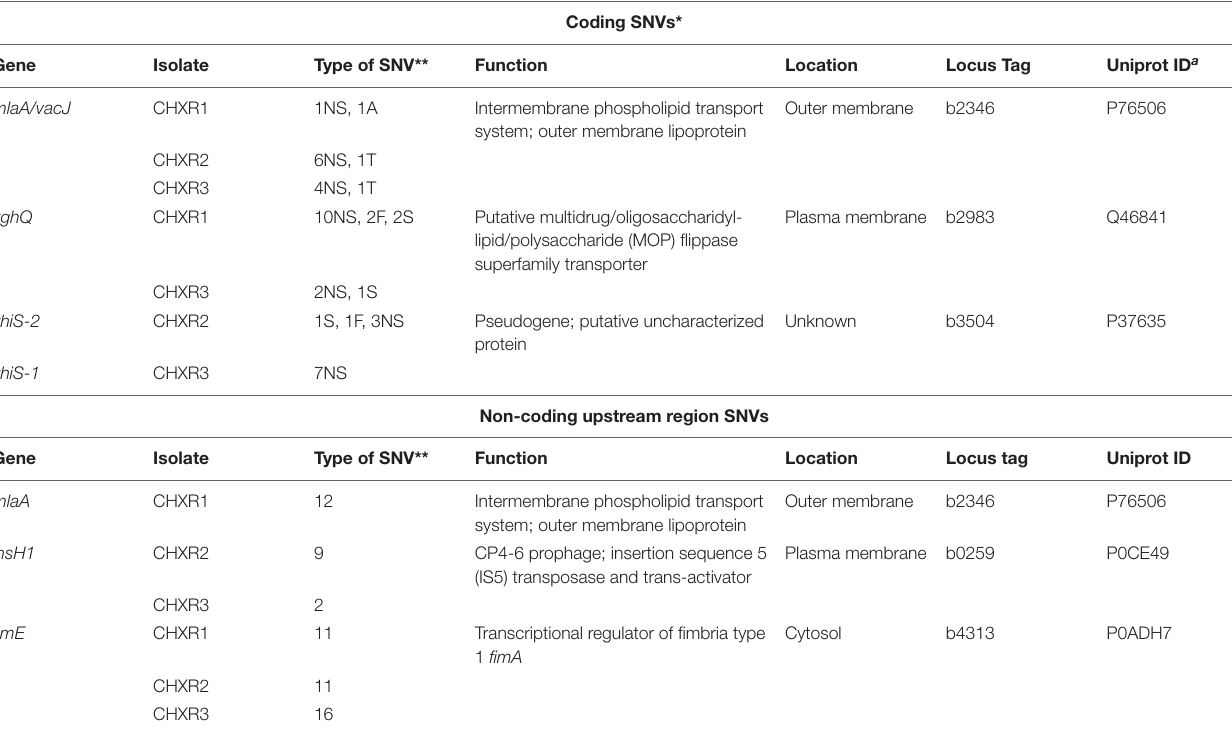
TABLE 4 | A summary of repetitive coding and non-coding SNVs identified from CHX-adapted genomes sequenced in this